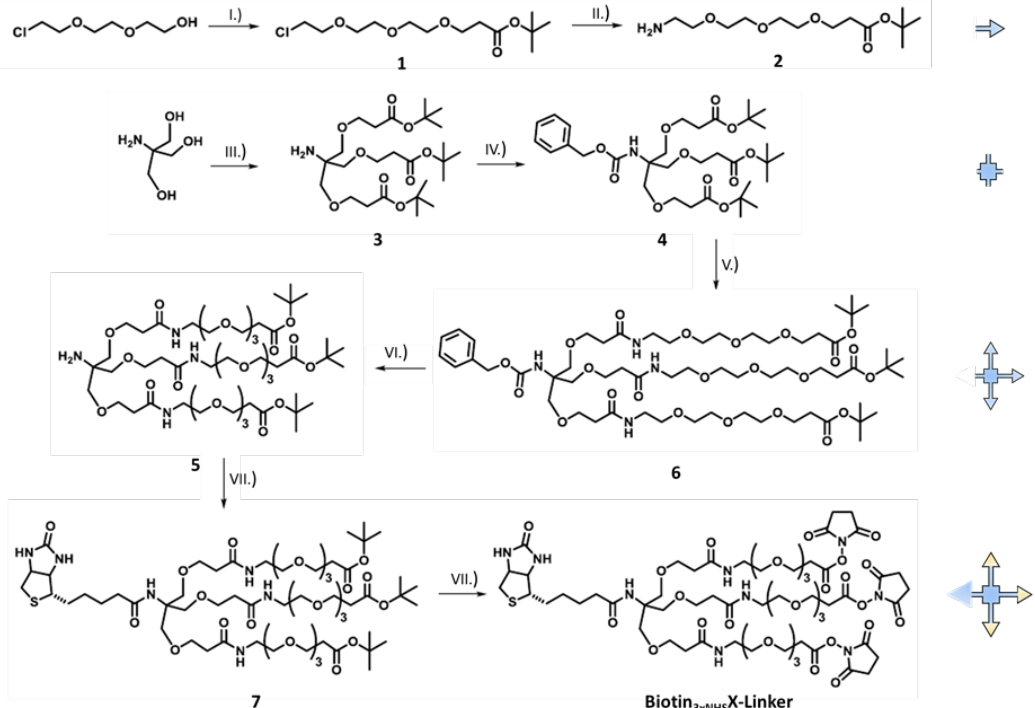
Figure 1. Synthesis of the Biotin 3xNHS X-Linker: ( I. ) t -butylacrylate, sodium, THF, 16h, 13%, ( II. ) 1.